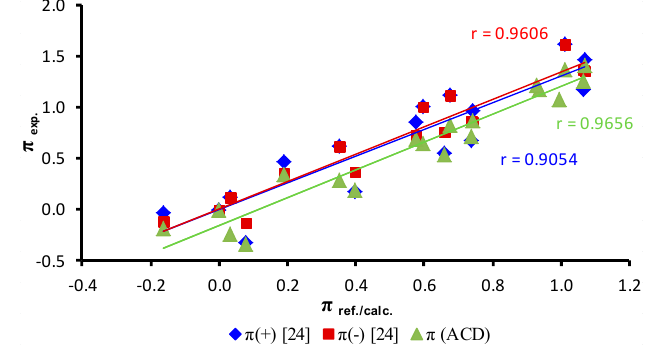
Figure 5. Comparison of values of experimentally determined parameters π of individual alkoxy substituents in ortho -, meta - and para -positions of an anilide ring with parameters π (+) , π ( − ) (ref. [24]) and calculated parameters π (ACD/Percepta).